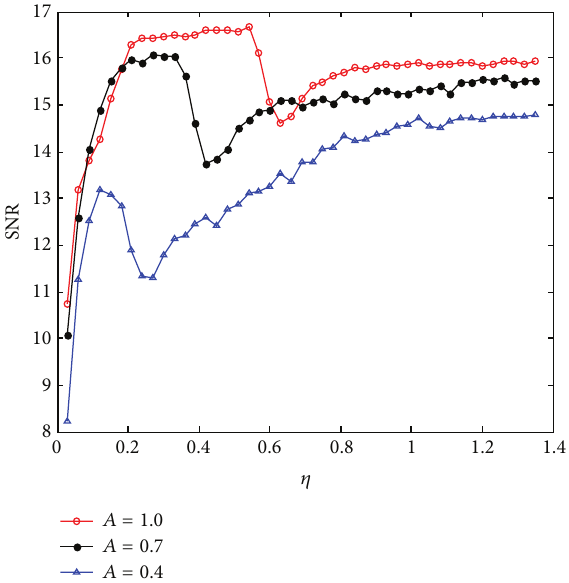
Figure 4: SNR versus the damping coefficient for the different amplitudes of the